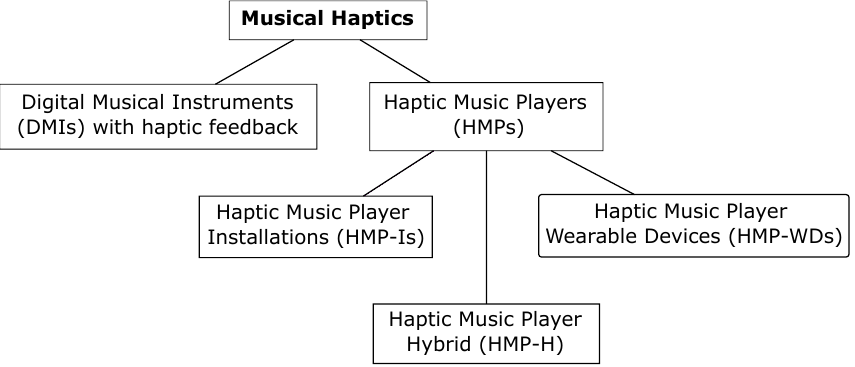
Figure 2. Preliminary classification of musical